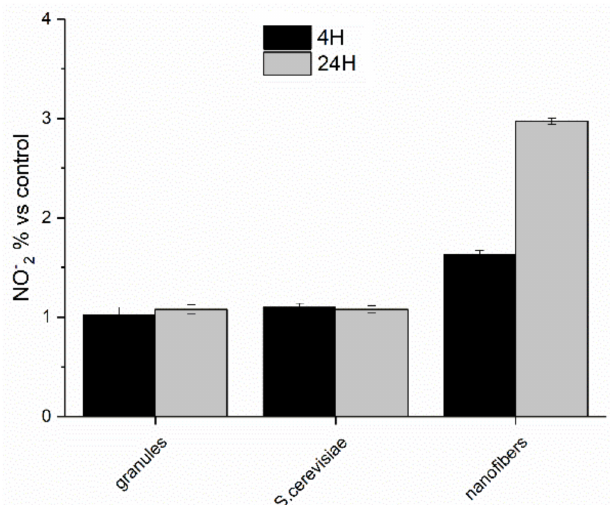
Figure 10. Nitric oxide production by PBMC cells stimulated with paramylon granules, S. cerevisiae preparation, and paramylon nanofibers 4 and 24 h, expressed as percent nitrite concentration versus control and plotted as the mean ± SD.